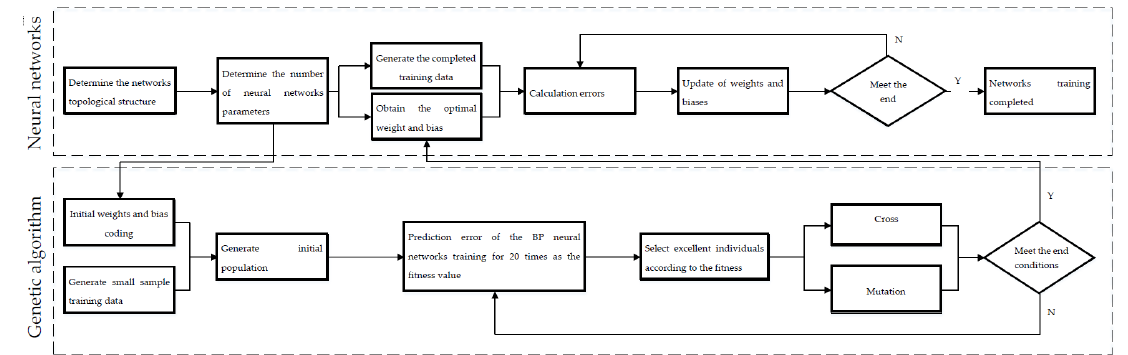
Figure 2. Algorithm flowchart of GA-BP.